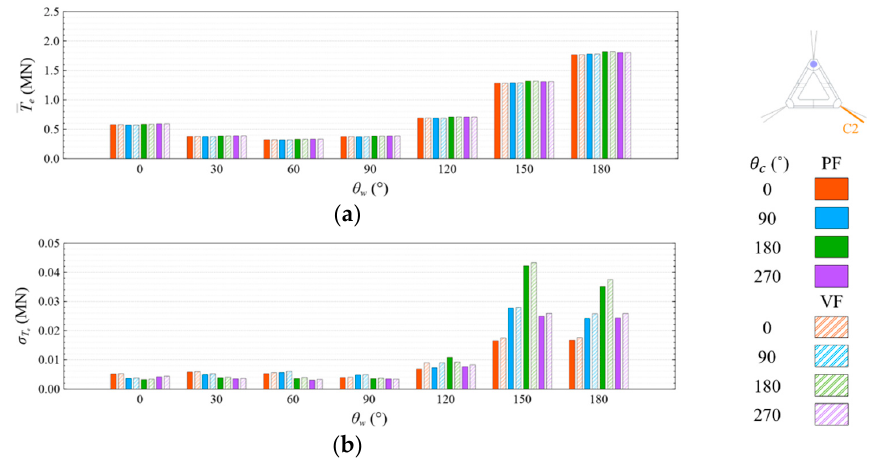
Figure 33. Comparison of ( a ) means and ( b ) standard deviations of mooring line tension of Line C2 under CW condition.